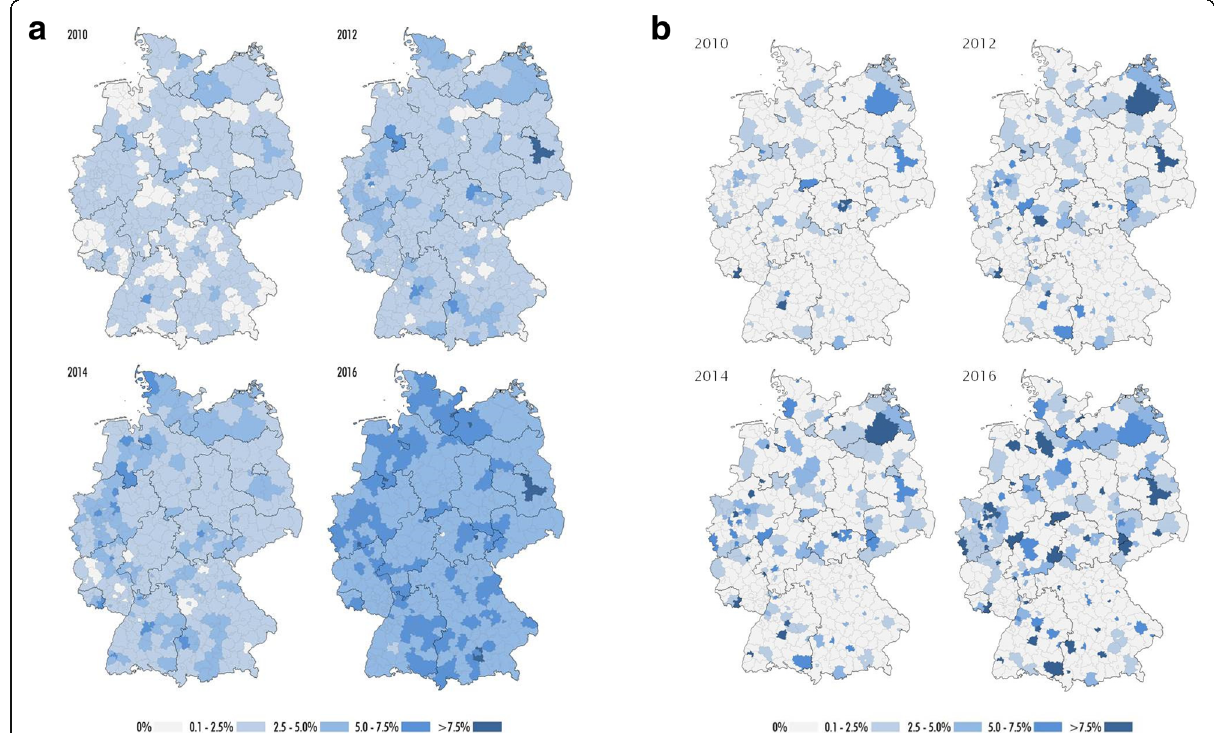
Fig. 4 a Maps of temporal and regional evolution of mechanical thrombectomy rates in Germany from 2010 to 2016 according to places of residence of the patients. b Maps of temporal and regional evolution of mechanical thrombectomy rates in Germany from 2010 to 2016 according to places of treatment in